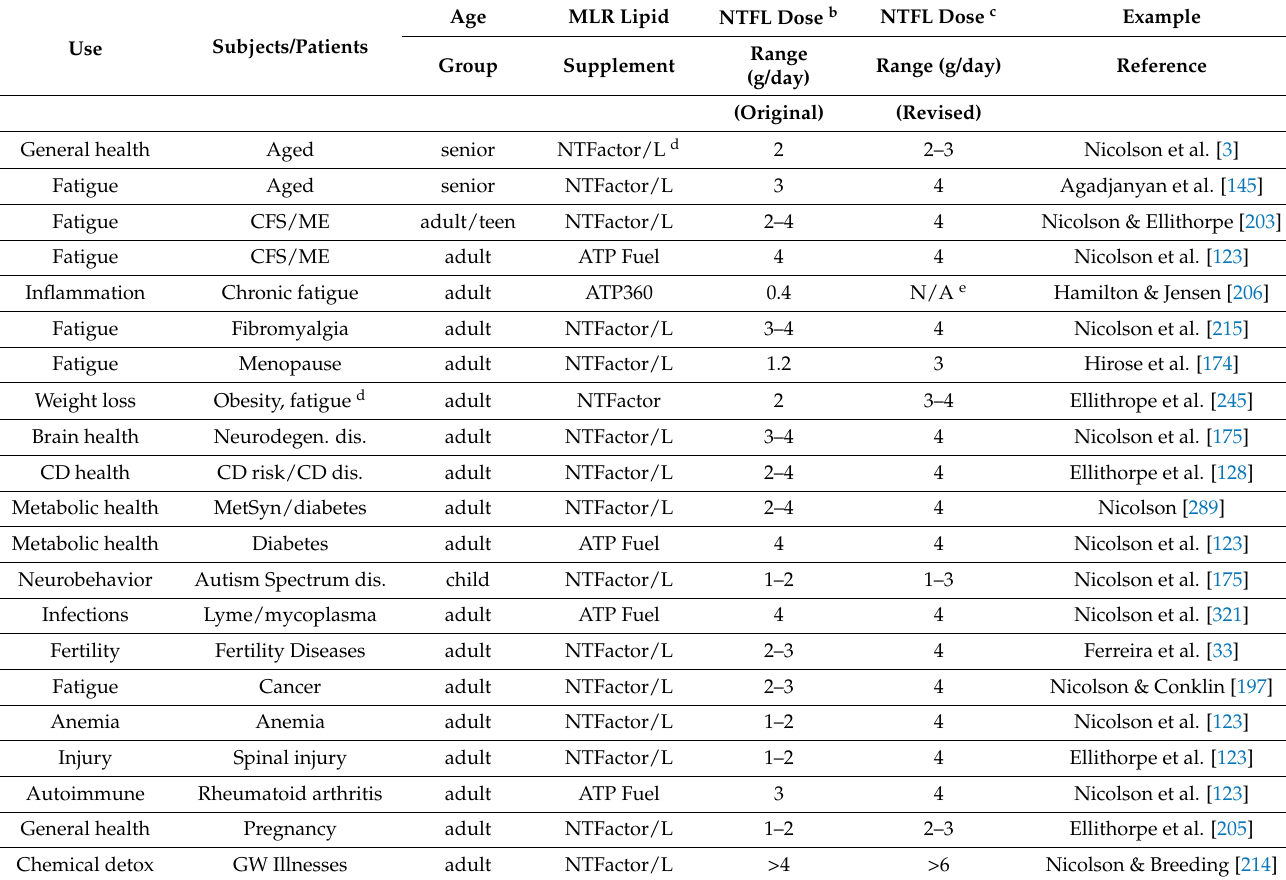
Table 1. Current and potential uses of oral MLR supplements and revised dose levels a